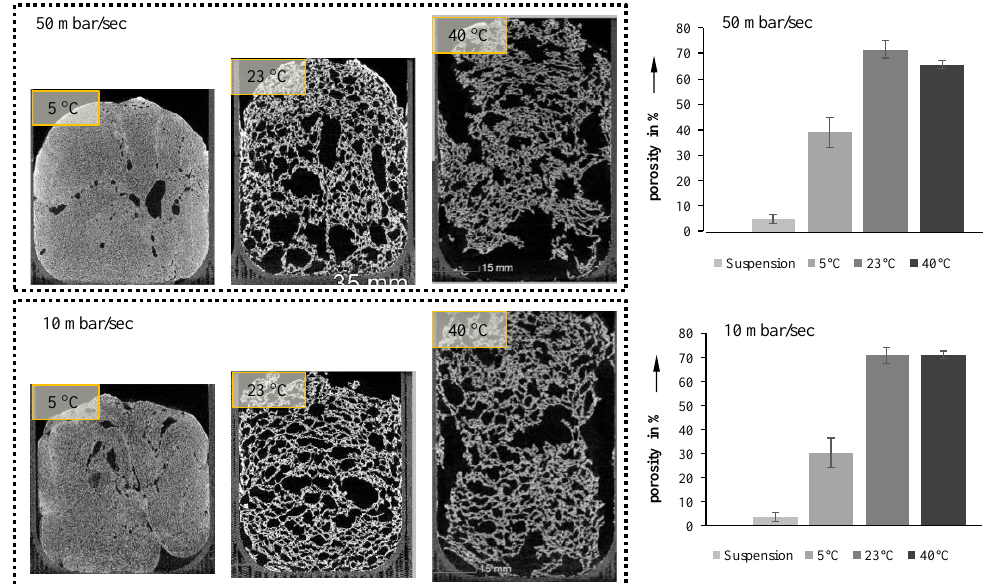
Figure 6. Cross-sections and porosities of completely foamed suspensions at two pressure reduction rates and three temperatures.